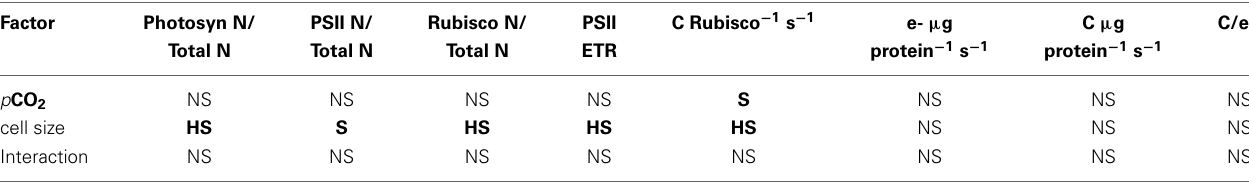
Table 1 | Results of Two-Way ANOVA, testing if p CO 2 or cell size had individual or interactive effects on key parameters. Factor